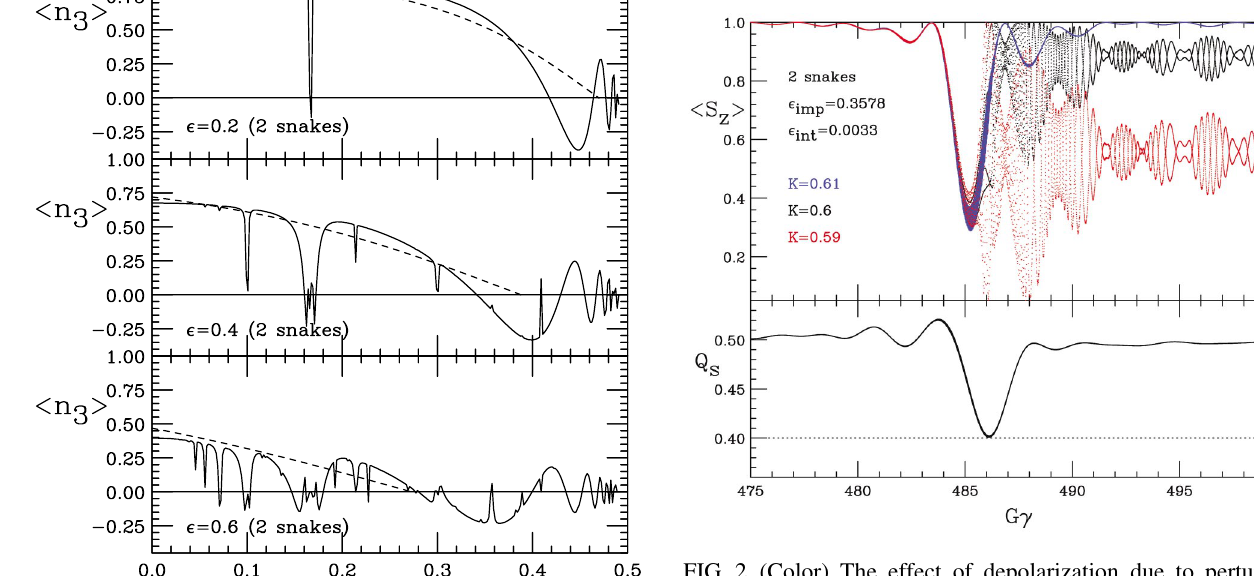
FIG. 2. (Color) The effect of depolarization due to perturbed spin tune shift on the spin. The model contains an imperfection and a weak intrinsic spin resonances in an accelerator with two i (cid:1) A i after acceleration FIG. 1. The expression h n (solid curve), is compared snakes. The top plot shows the value of h S z 3 0 i (dashed curve) calcu- with an approximate expression for h S across the resonance region. The bottom plot shows the per- 3 . Plots for three intrinsic tune values K (cid:1) lated using the perturbed spin tune, as a function of the reso- turbed spin tune Q s nance tune K ( K (cid:1) 0 to 0.5) for a single resonance model 0 : 59 , 0.6, and 0.61 are shown. Note that the imperfection spin resonance produces a spin tune shift, and the depolarization is with two snakes. Three plots are shown, for resonance driving clearly observed when the tune of the intrinsic spin resonance terms with amplitudes (cid:11) (cid:1) 0 : 2 (top plot), 0.4 (center), and 0.6 overlaps with the perturbed spin (bottom).